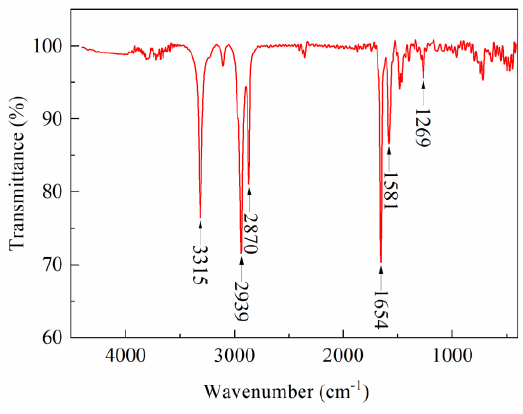
Figure 1. Infrared spectra of TQ-1.